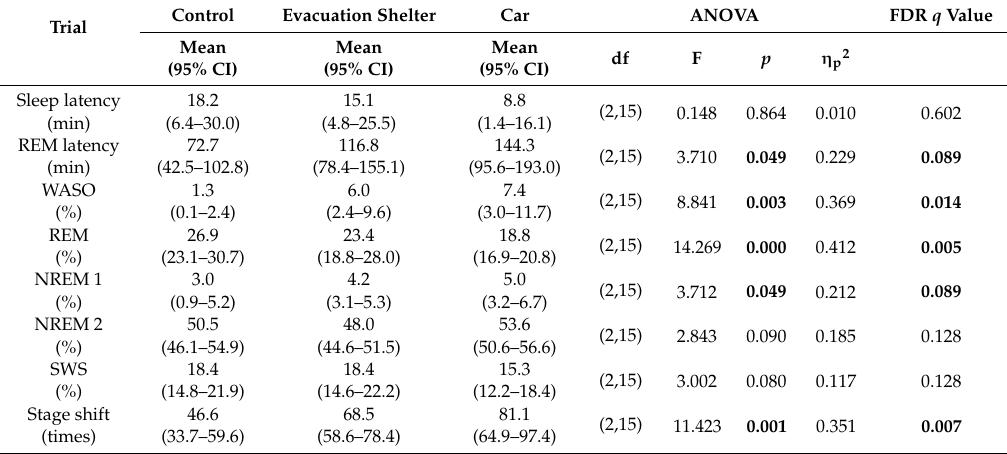
Table 1. Results of sleep stages using the portable two-channel electroencephalogram monitoring system ( n =